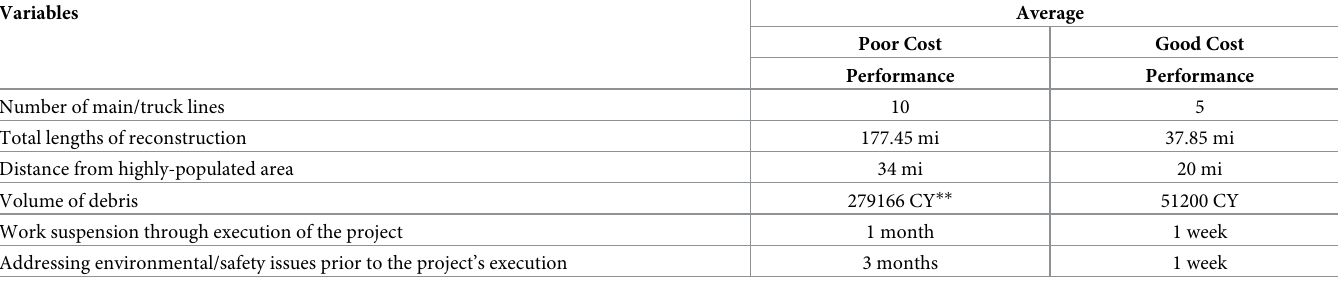
Table 5. Comparison of variables with continuous data in reconstruction projects with good and poor cost